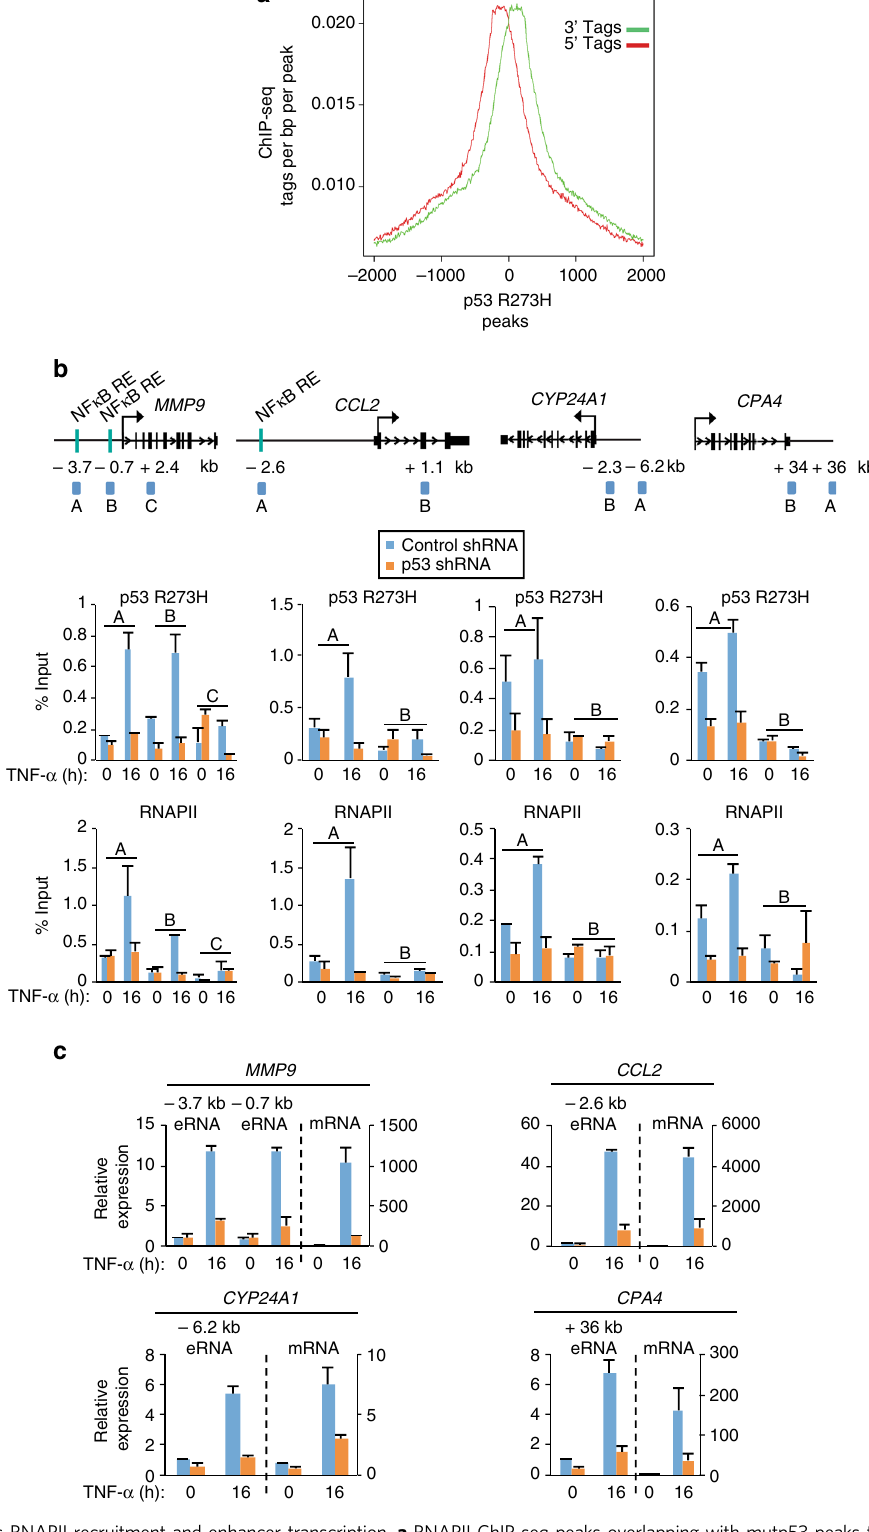
Fig. 5 Mutp53 regulates RNAPII recruitment and enhancer transcription. a RNAPII ChIP-seq peaks overlapping with mutp53 peaks following 16h TNF- α treatment. b ChIP-qPCR analyses of p53 R273H and RNAPII enrichment at MMP9 , CCL2 , CYP24A1 , and CPA4 enhancers in SW480 cells expressing control (LacZ) or p53 shRNA and treated with TNF- α for 0 or 16h. An average of two independent ChIP experiments that are representative of at least three is shown with error bars denoting the standard error. The amplicons used for ChIP-qPCR are shown in the schematics and were designed to recognize the enhancer (A and B at MMP9 and A at CCL2 , CYP24A1 , and CPA4 ) or non-speci fi c (C at MMP9 and B at CCL2 , CYP24A1 , and CPA4 ) regions of the target gene loci. c qRT-PCR analyses of the indicated eRNAs and mRNAs in SW480 cells treated as described in ( b ). The expression levels shown after TNF- α treatment are relative to the levels before treatment. The bar graphs represent the average of three independent experiments with the error bars denoting the standard error NATURE COMMUNICATIONS | 8: